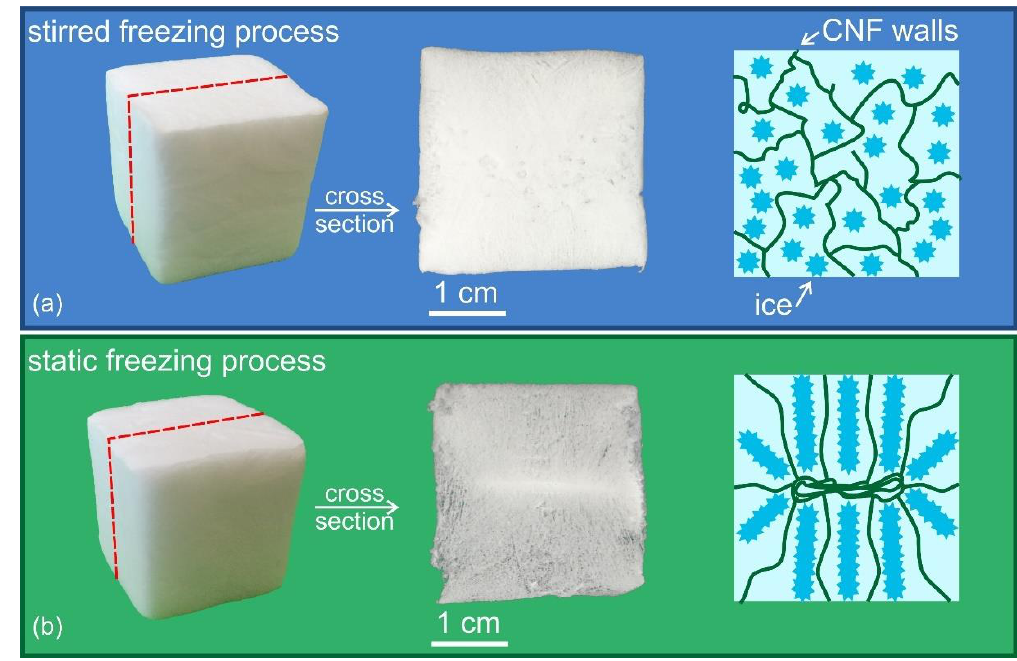
Figure 4. CNF foams produced via the stirred freezing process ( a ), with CNF concentration equal to 1.6 wt%, and foams formed by the static freezing process ( b ), with CNF concentration equal to 1 wt%. The images on the left are the final dry cubic foams and the center images show the sample cross sections. On the right side, schematic images highlight that, in the stirred freezing process, the stirring process leads to a more homogeneous distribution and orientation of ice crystal (blue stars) compared to the static freezing process, where a preferential growth of the ice crystals, from the external surface to the center of the sample, and a less homogeneous CNF (green lines) distribution is observed. Samples were cut using a razor blade for inspection of the cross section.